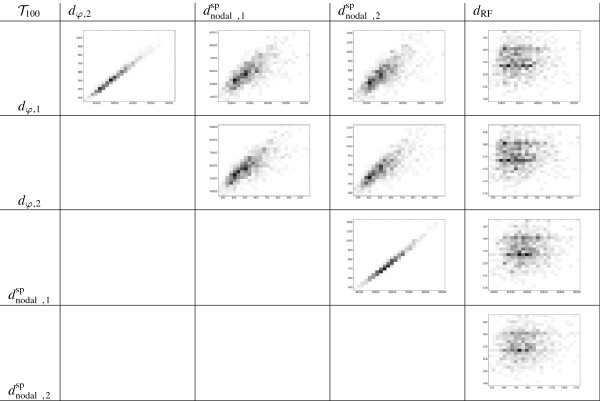
2D-histograms showing the relationship between different distances onT100.